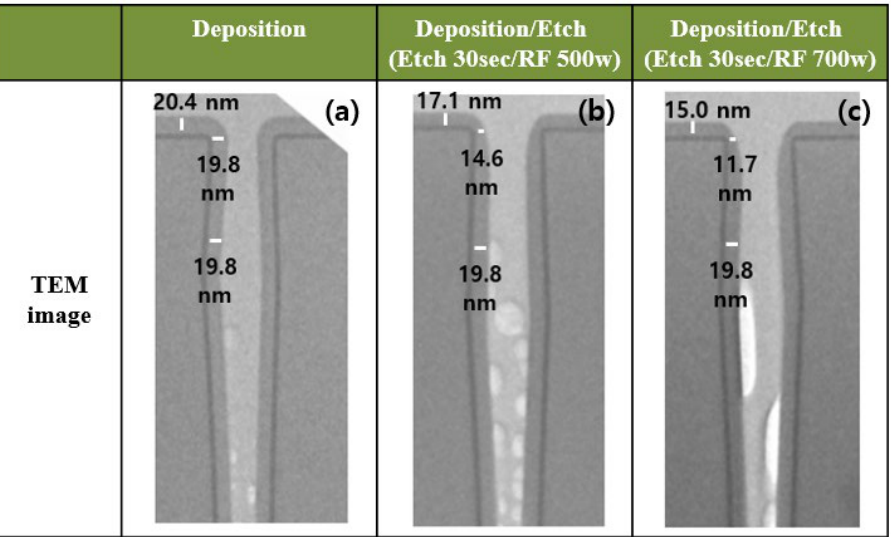
Figure 11. Analysis of the influence of etching in the pattern. ( a ) Pattern image when deposited only. ( b ) Pattern image when deposited by increasing RF power (500 w). ( c ) Pattern image when deposited by increasing RF power (700 w)